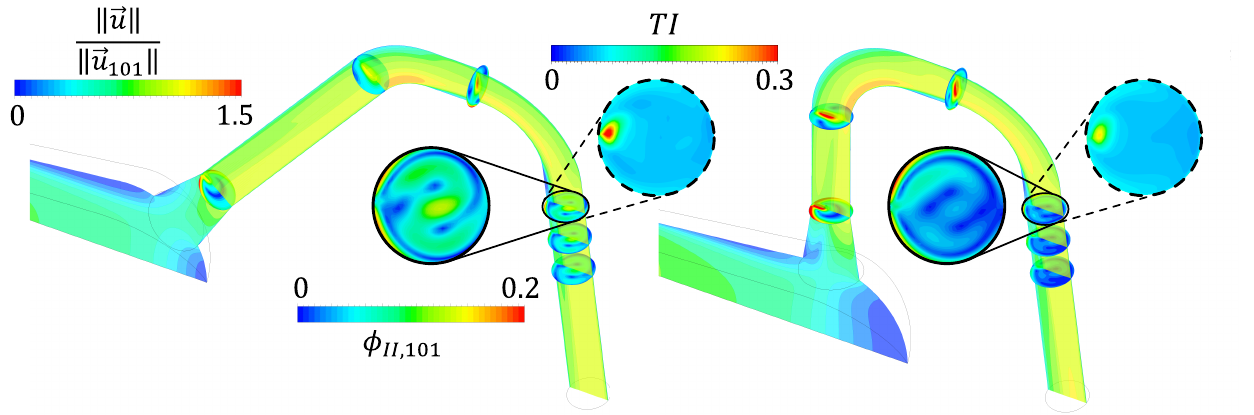
Figure 12. Contour plots of the basic model with conical frustum (basic design b). The plots on the left show the model with a deviation angle of δ = 50 ◦ , and the model on the right has a deviation angle of δ = 90 ◦ . The contours on the mid-plane show normalised velocities, the contours encircled in solid black show secondary velocity ratios, and the contours encircled by dashed black lines show (cid:114) 2 k the turbulent intensity TI = 3 (cid:107) (cid:126) u 101 (cid:107) 2